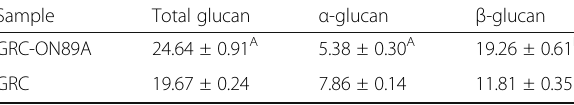
Table 1 β -glucan content in the GRC-ON89A and GRC Sample